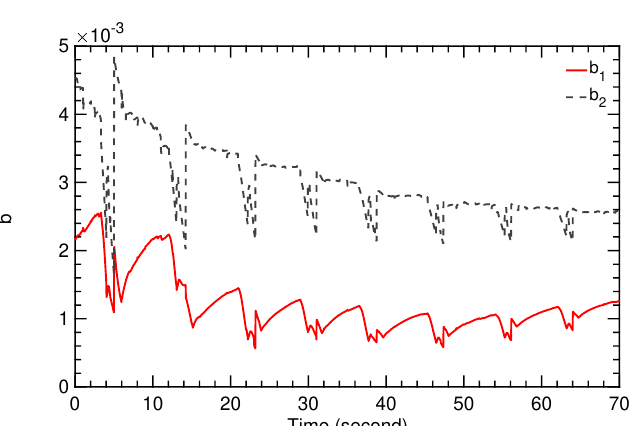
Figure 11. Time history of TF coefficients a 1 and a 2 .